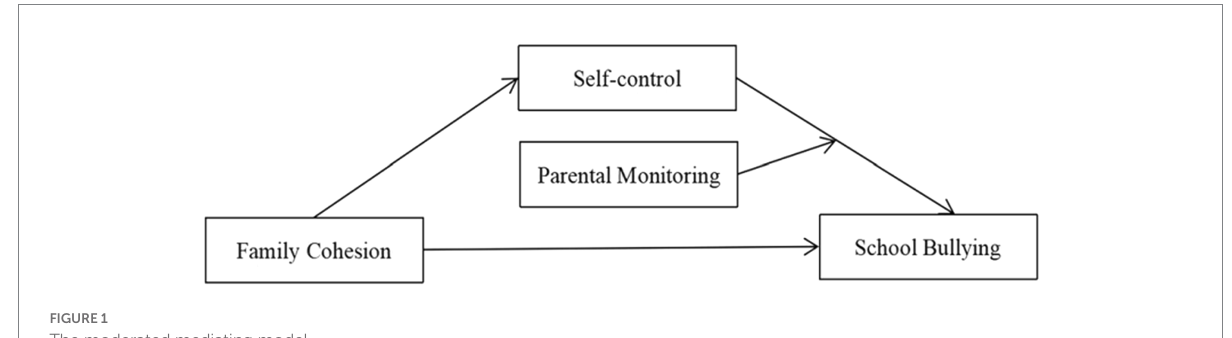
FIGURE 1 The moderated mediating